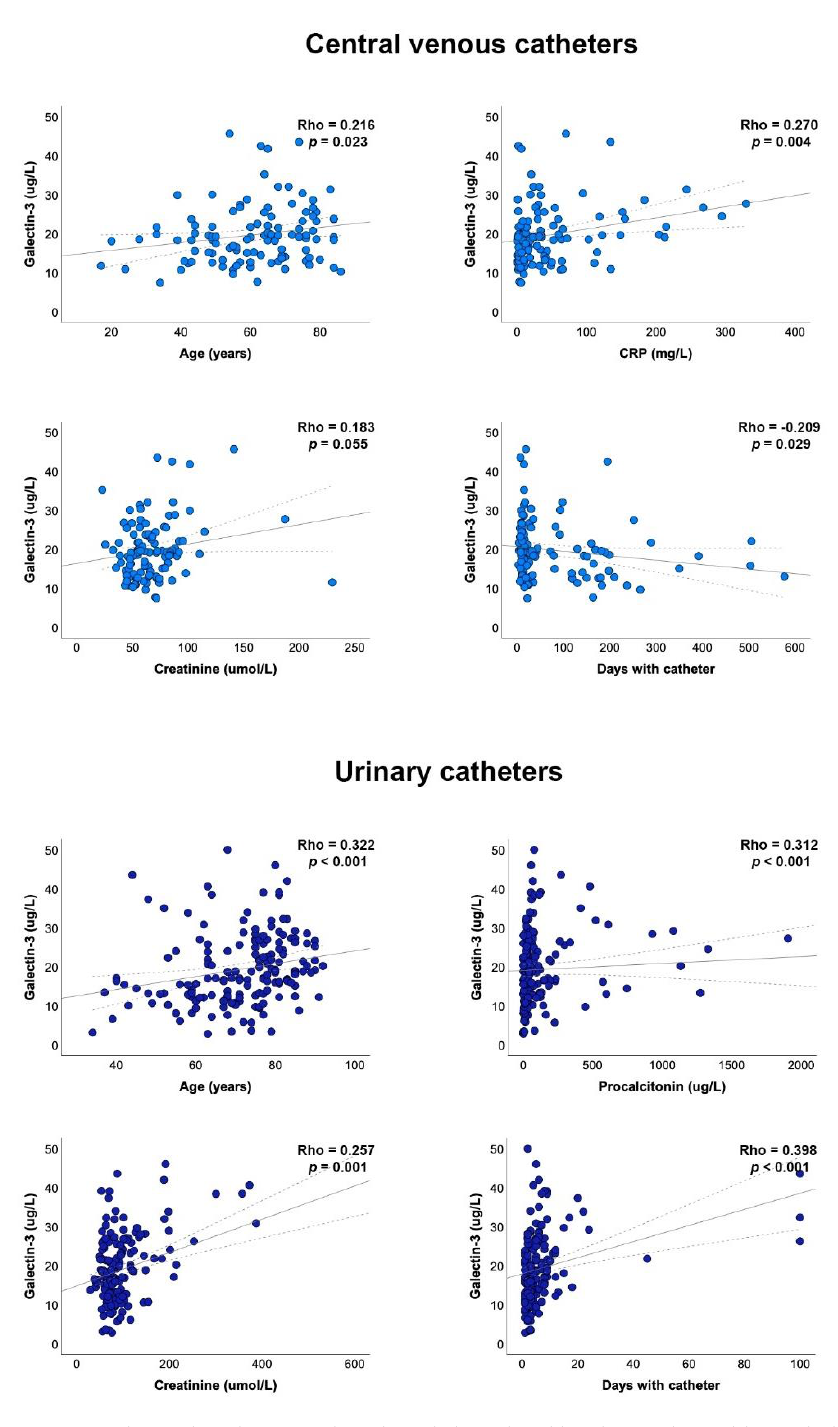
Figure 2. Relationships between the selected clinical and biochemical variables and plasma galectin-3 concentrations in the catheter-bearing patients. Statistical analyses used Spearman’s Rho test.